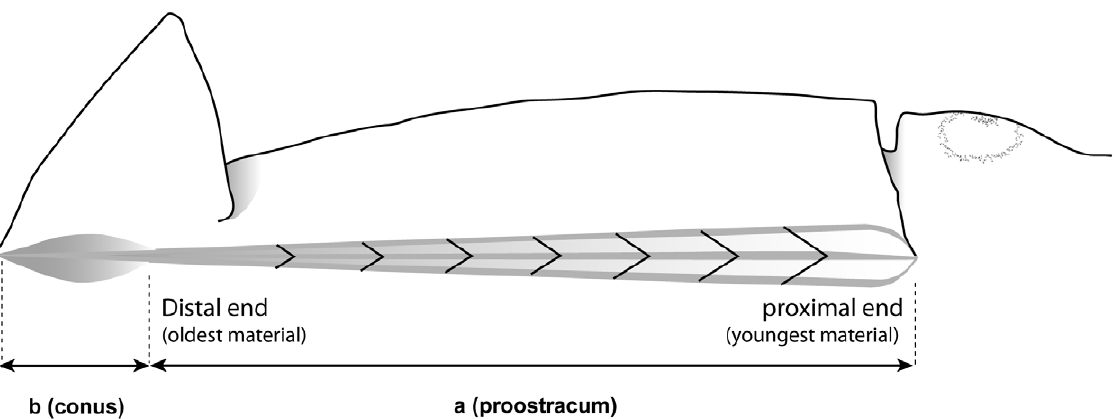
Figure 1. Jumbo squid gladius and isotopic sampling. Schematic dorsal view of Dosidicus gigas gladius (adapted from Perez et al. 1996). Sampling was done through 1 cm sections along the gladius proostracum (a) without sampling the conus (b) following the V-shape of the growth lines. Sections close to the proximal end correspond to the most recent formed material and to the oldest age of squid.